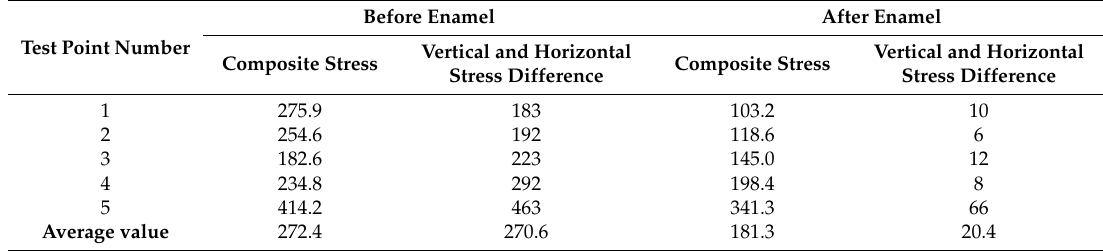
Table 11. Residual stress comparison before and after enameling of longitudinal weld.